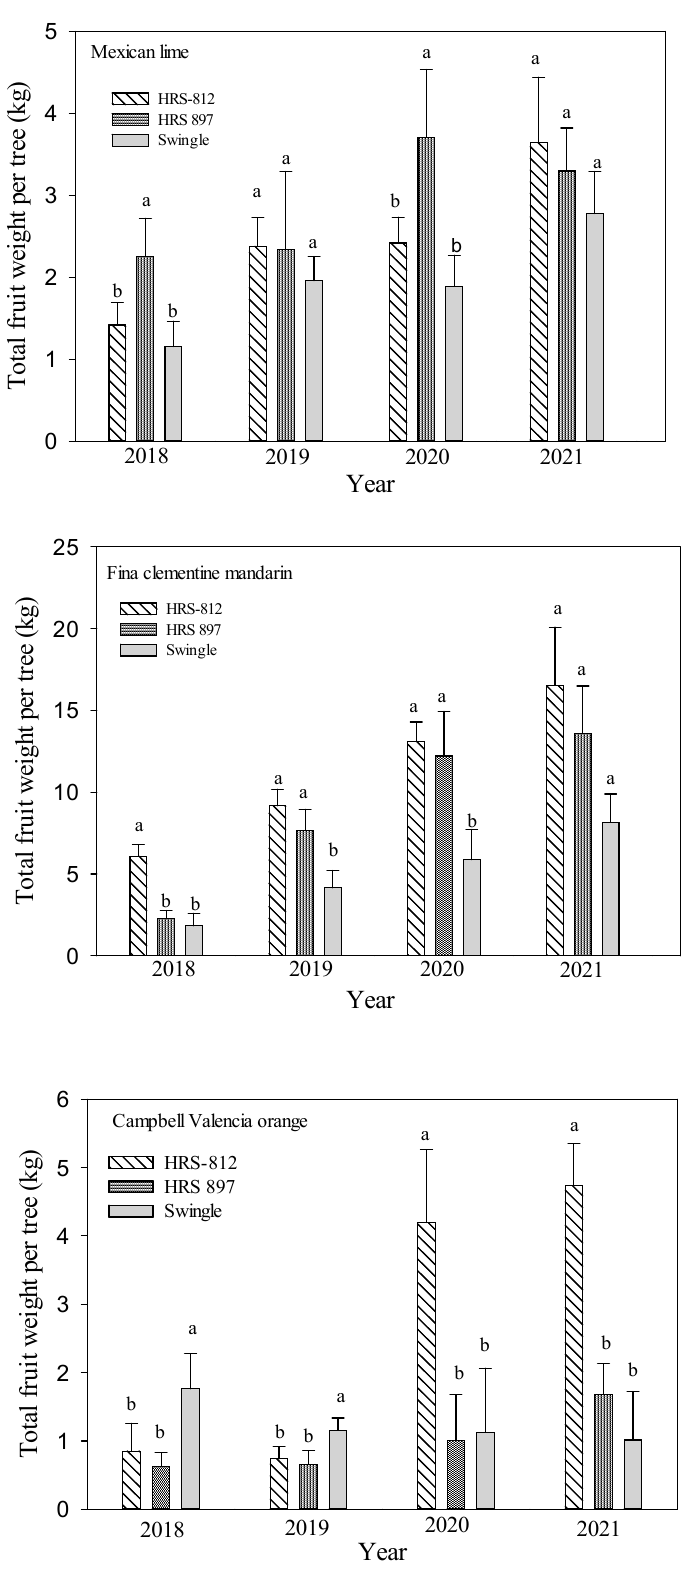
Figure 3. Total fruit weight in kg per tree (2018–2021) of ‘Mexican’ lime, ‘Fina’ clementine mandarin, and ‘Campbell’ Valencia orange grafted in three different rootstocks growing in Coto series soil at the Agricultural Experiment Substation of Isabela, Puerto Rico. Means ± standard error with different letters for each scion and year are not significantly different according to Tukey’s test at α < 0.05.